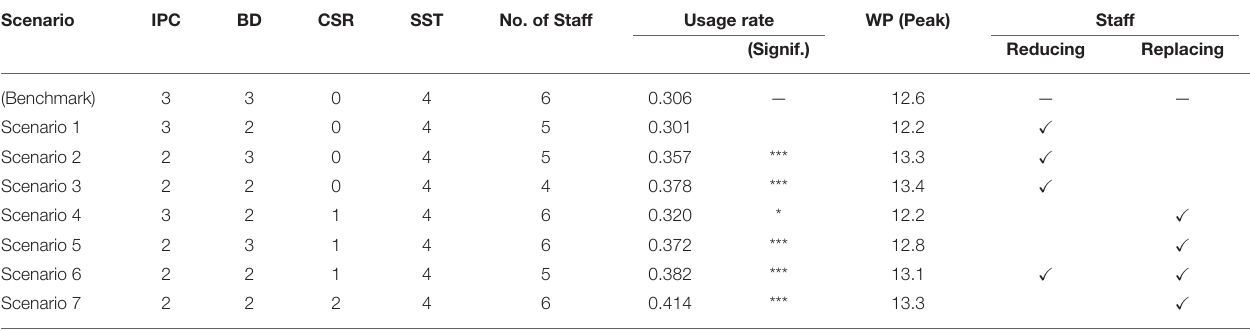
TABLE 6 | Results of experimental scenario.